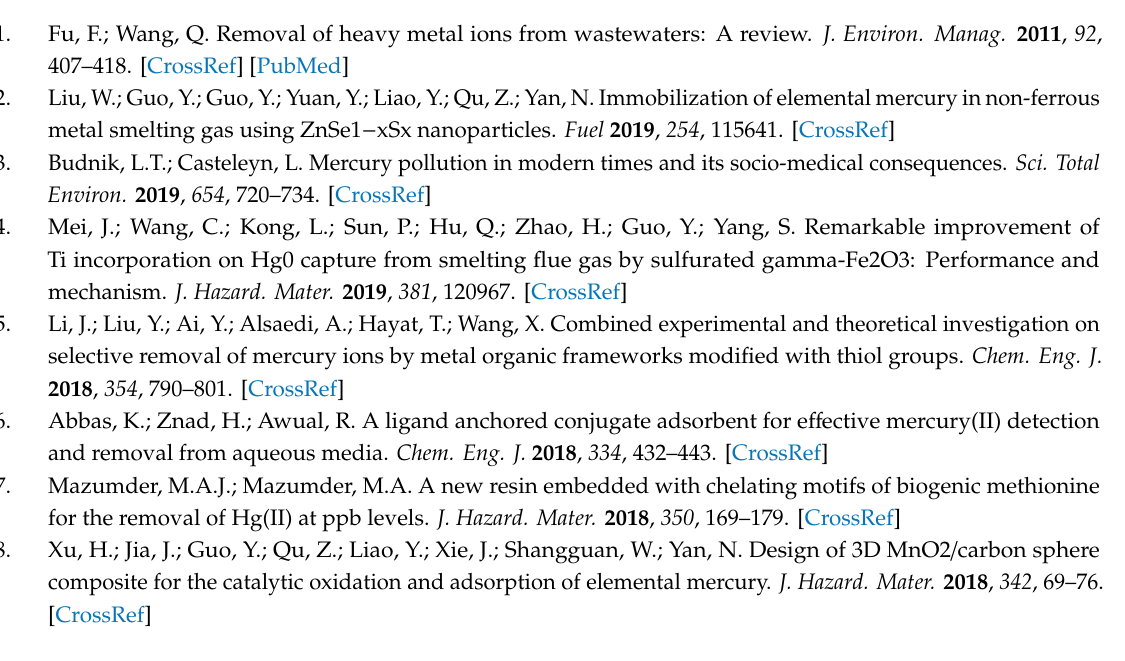
Figure S1: E ff ect of adsorbent dosage; Figure S2: SEM and EDS micrographs; Figure S3: XRD graph of the materials; Figure S4: E ff ect of coexisting ions; Table S1: N 2 adsorption-desorption isothermal data; Table S2: Mass percentage of each element in PPy-Fe 3 O 4 / Kaolin; Table S3: CCD matrix and running results obtained by PPy-Fe 3 O 4 / Kaolin; Table S4: Results of ANOVA of Quadratic mode; Table S5: Comparison of adsorption capacity of mercury by di ff erent